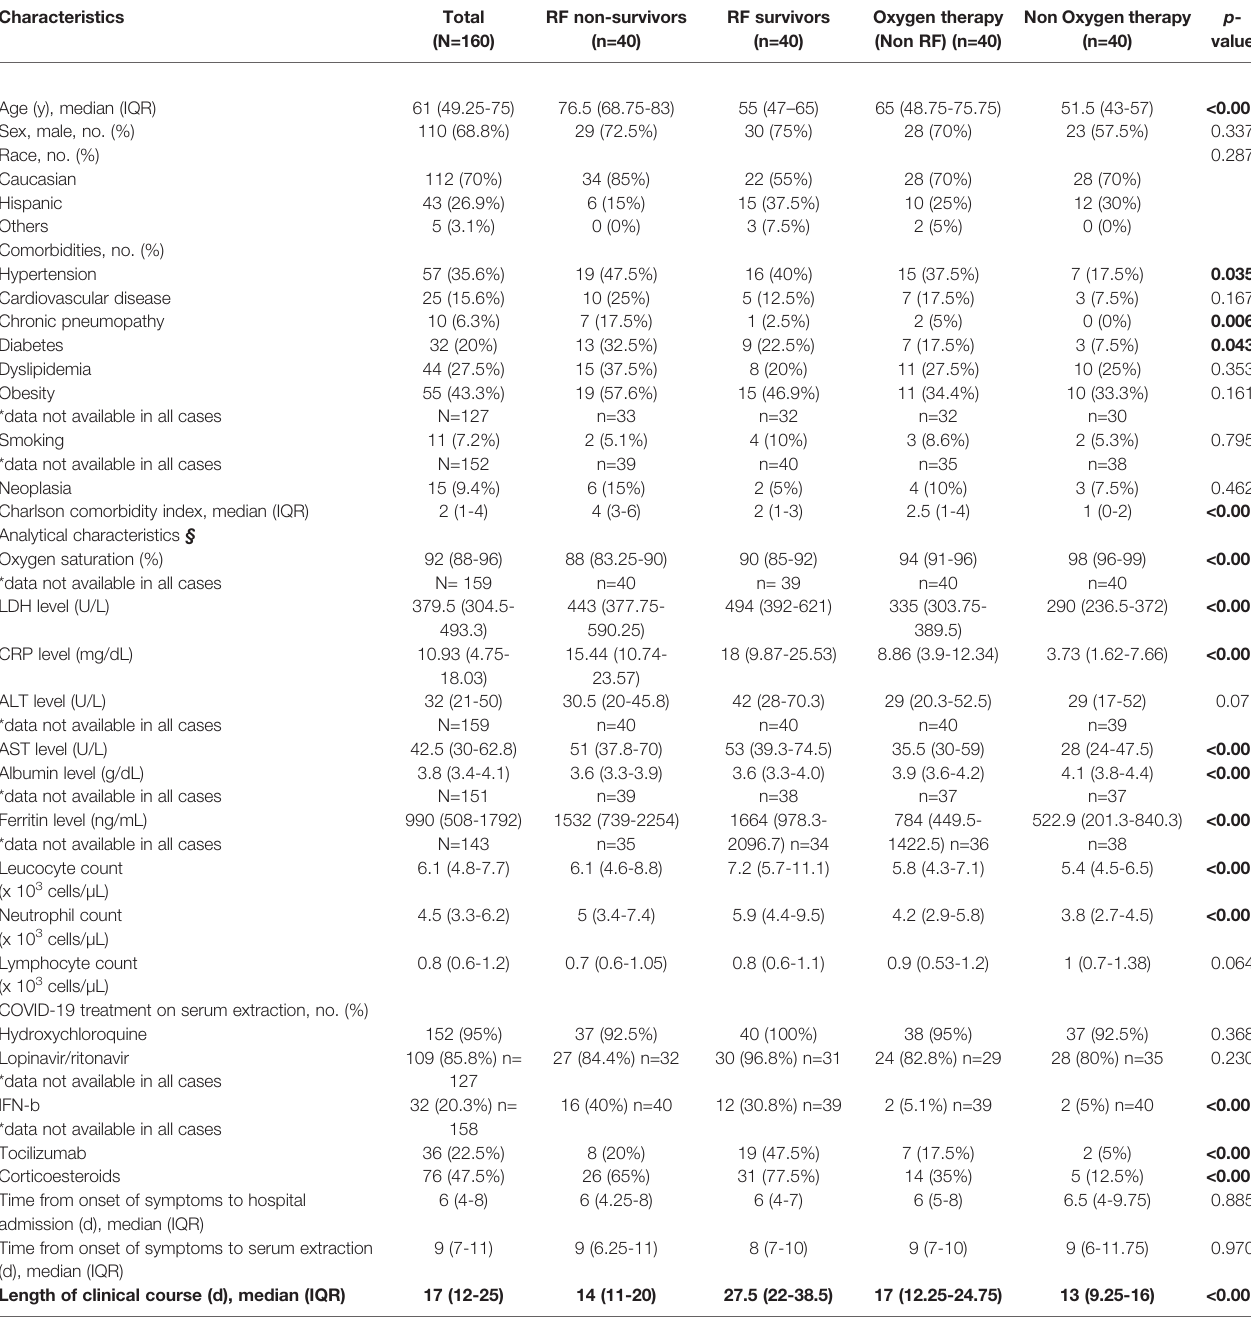
RF, respiratory failure. § represented median and interquartile range. Bold values indicate stastisticaly